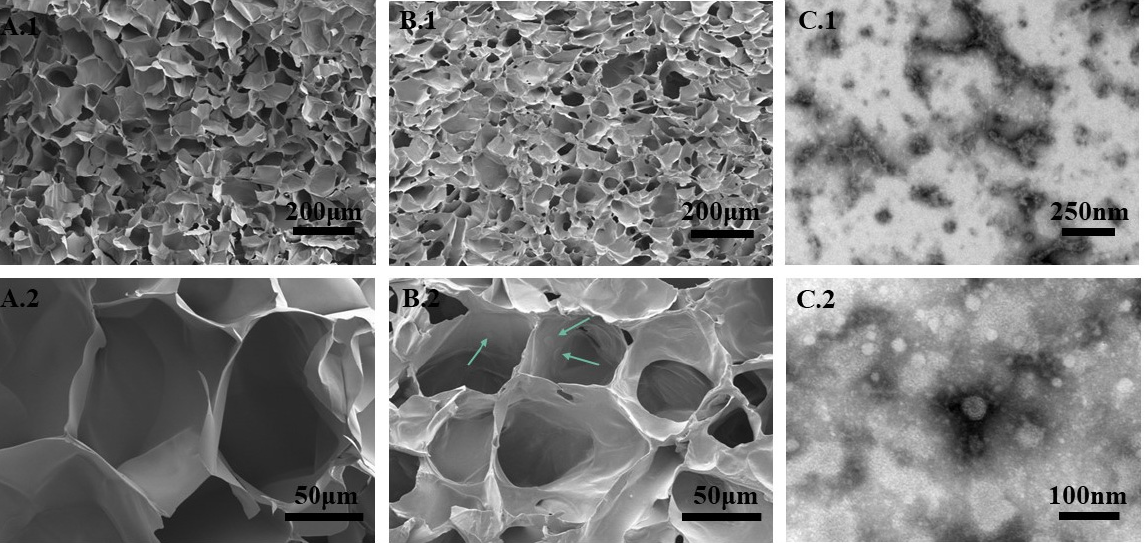
Figure 4. Microscopic examination of gels and dissolved samples. ( A ) Blank gel, ( B , C ) IPC-DNV-TSG at different magnifications. ( A , B ) are SEM images, C are TEM images. 1 indicates low magnification (×100), and 2 indicates high magnification (×200).